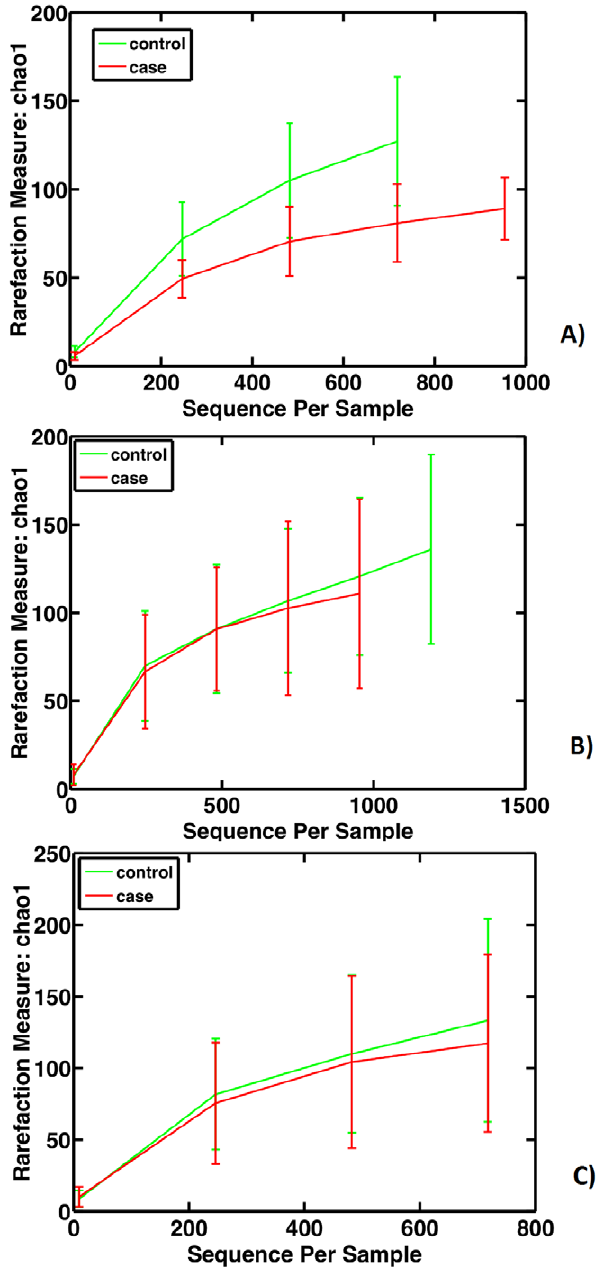
Figure 2. Chao rarefaction diversity. Chao diversity was calculated from sequence distribution A) 2 weeks before; B) 1 week before; and C) within 72 hours of LOS diagnosis. Error bars indicate SE.